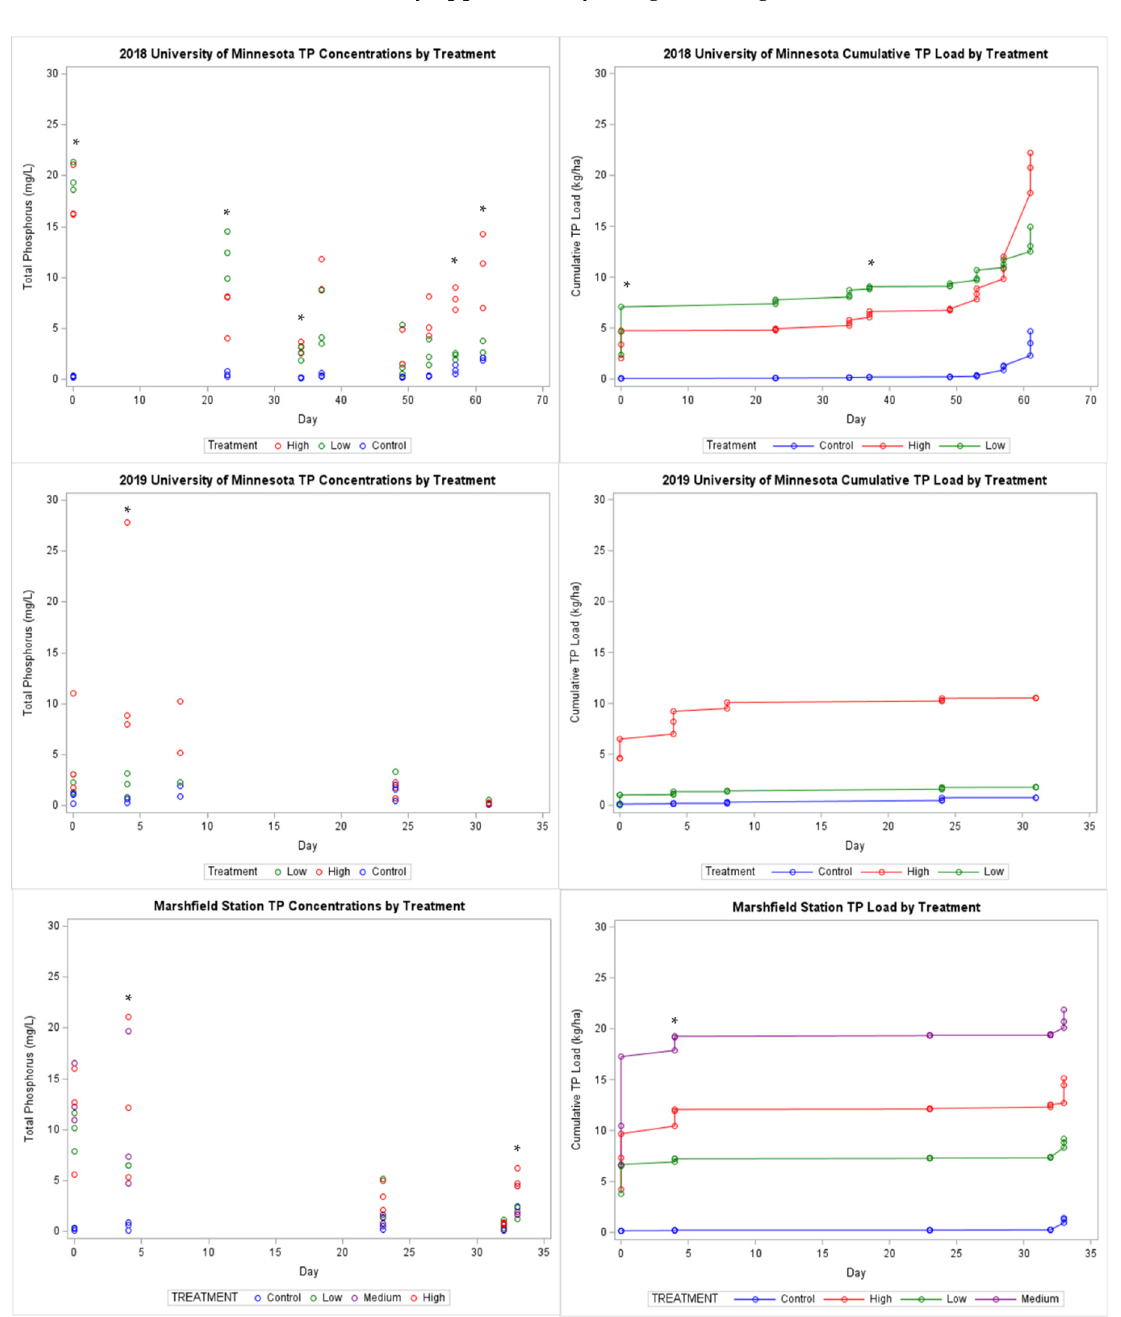
Figure 5. Snowmelt runoff total phosphorus (TP) concentrations/loads by treatment for each site and year of the experiment. Asterisks indicate a significant ( p ≤ 0.05) main effect of manure